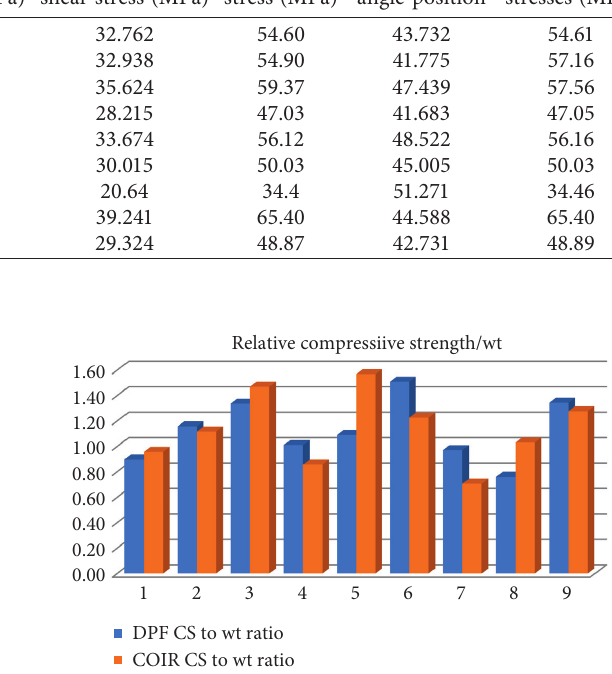
Figure 11: Relative strength/weight ratios of composites.